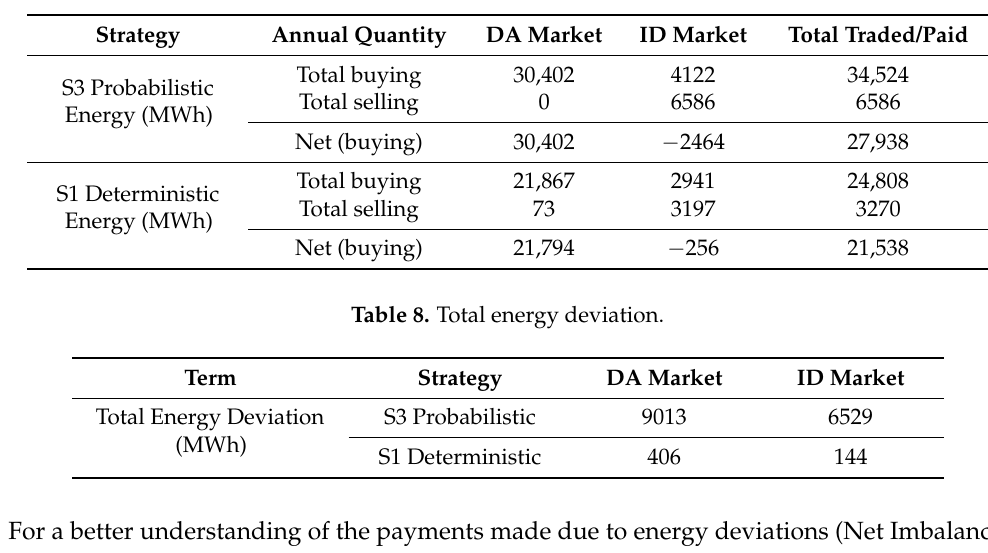
( a ) ( b ) Figure 7. ( a ) PDF of the energy deviation after the intraday market; ( b ) PDF of the payment/revenue due to deviation after the intraday market. Regarding the payment/revenue derived from the energy deviations, it can be seen in Figures 6b and 7b that:  Using the deterministic strategy S1, its variability after the ID market decreases compared to the variability after the DA market, but with the probabilistic strategy S3, the payment/revenue variability increases after the ID market.  With the probabilistic strategy S3, the PDFs present a right-skewed distribution compared to the deterministic S1, which means that the probability of the aggregator to be remunerated for a positive imbalance is higher with S3 than with S1. Thus, the probabilistic approach tends to maximize the revenue due to positive deviations and minimize the payment due to the negative deviations. The deterministic strategy does not consider this, leading to a higher payment. The probabilistic strategy may also benefit from arbitrage between the ID markets and the imbalance prices, selling or buying in the ID market, when the expected imbalance price is, respectively, lower or higher than the forecasted intraday market price. Of course, this strategy might lead to occasional losses, but the overall results are favorable. Risk-averse strategies to limit these losses are less profitable in the long term [20]. Overall, the proposed method has a good performance and the computation time is reduced (the computation time of both problems (day-ahead plus intraday) for a planning period of 24 h is around 15 s).